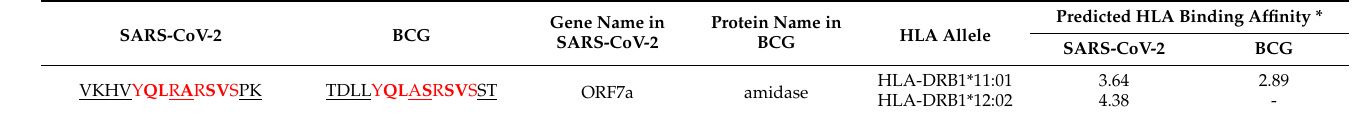
Table 11. Cross-reactive HTL epitopes between SARS-CoV2 and BCG. The amino acid substitution is indicated by underlining. The core epitope is highlighted in red color and bold font indicating the TCR contact